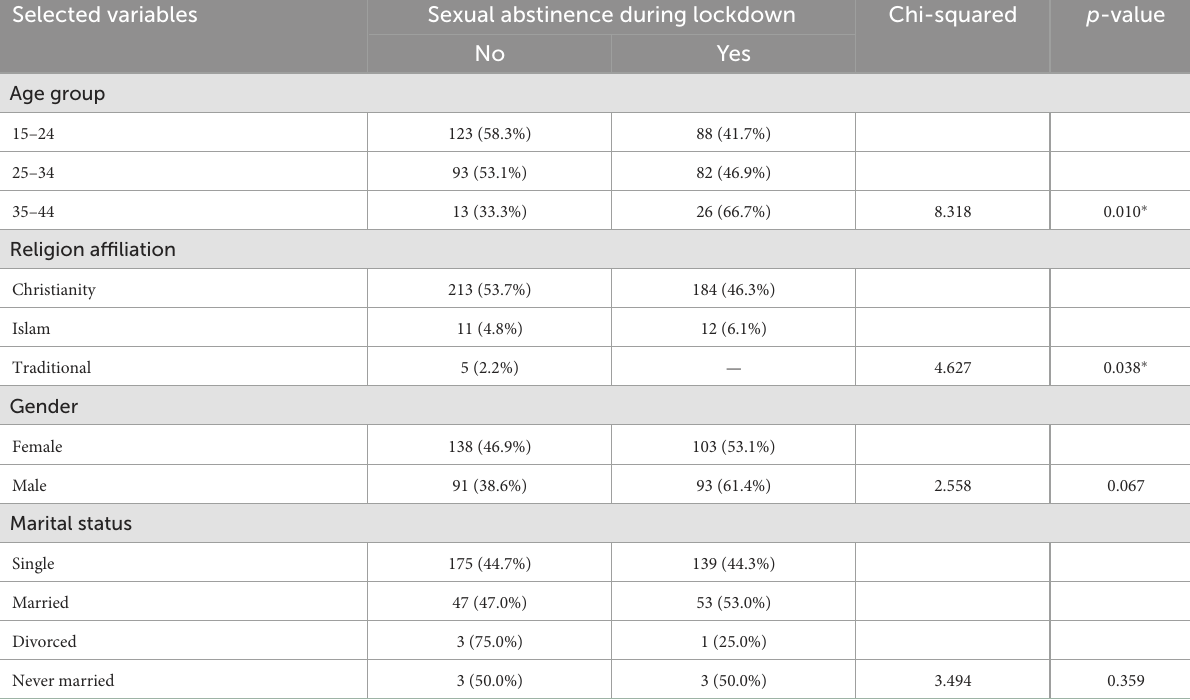
TABLE 3 Percentage distribution of selected background characteristics and ability for sexual abstinence during the COVID-19 lockdown. Selected